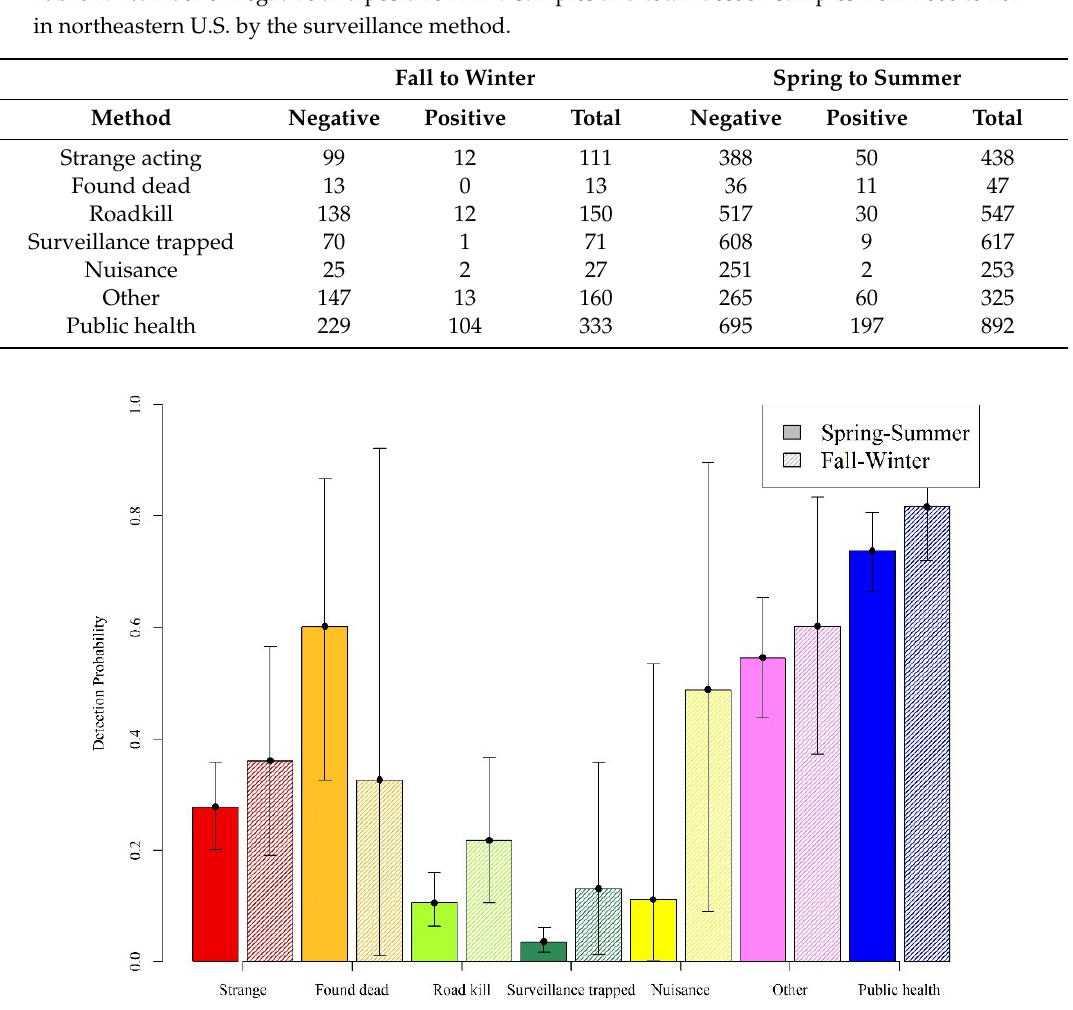
Figure 5. The probability of RABV detection by the surveillance method allowing for within year variability (spring to summer—solid colors; fall to winter—hashed bars). The colors correspond to surveillance method: strange acting in red, found dead in orange, roadkill in light green, surveillance trapped method in dark green, nuisance samples in yellow, other samples in violet, and public health samples in blue. The 95% credible intervals are shown per estimate.